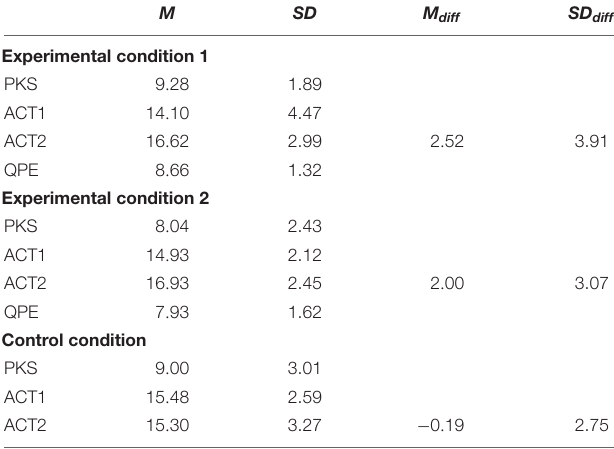
TABLE 8 | Descriptive statistics of Study